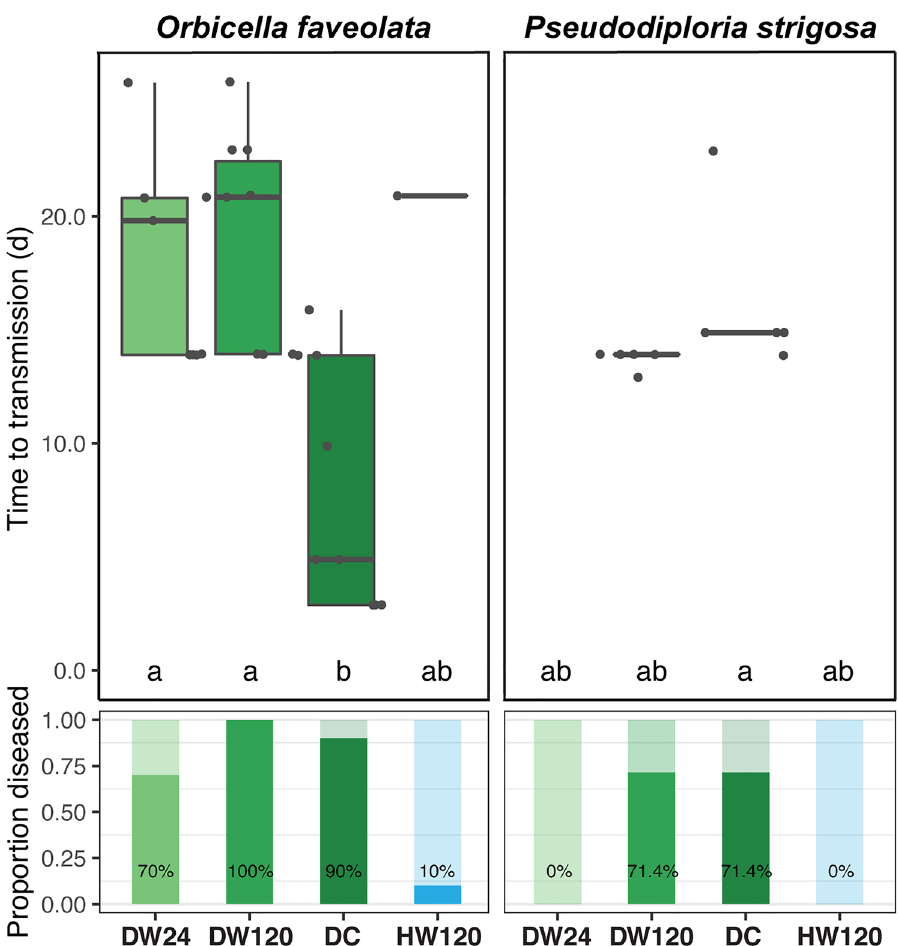
Figure 6. Ballast experiment transmission metrics. Mean time to initial observations of SCTLD lesions ± SEM (boxplots) and transmission rates (proportion of individuals exhibiting lesions). Colors denote treatments, and different letters denote significant differences among treatments. Treatment abbreviations are as follows: disease water 24 h (DW24), disease water 120 h (DW120), diseased coral direct contact (DC), and healthy water 120 h